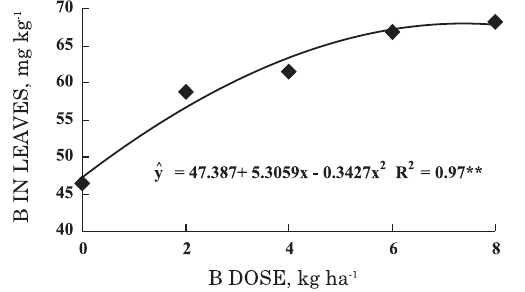
Figure 3. Boron concentration in sunflower leaf tissue as related to the B rate applied to soil. Table 4. Correlation coefficient between boron concentrations in soil and sunflower, according to depth and extractor